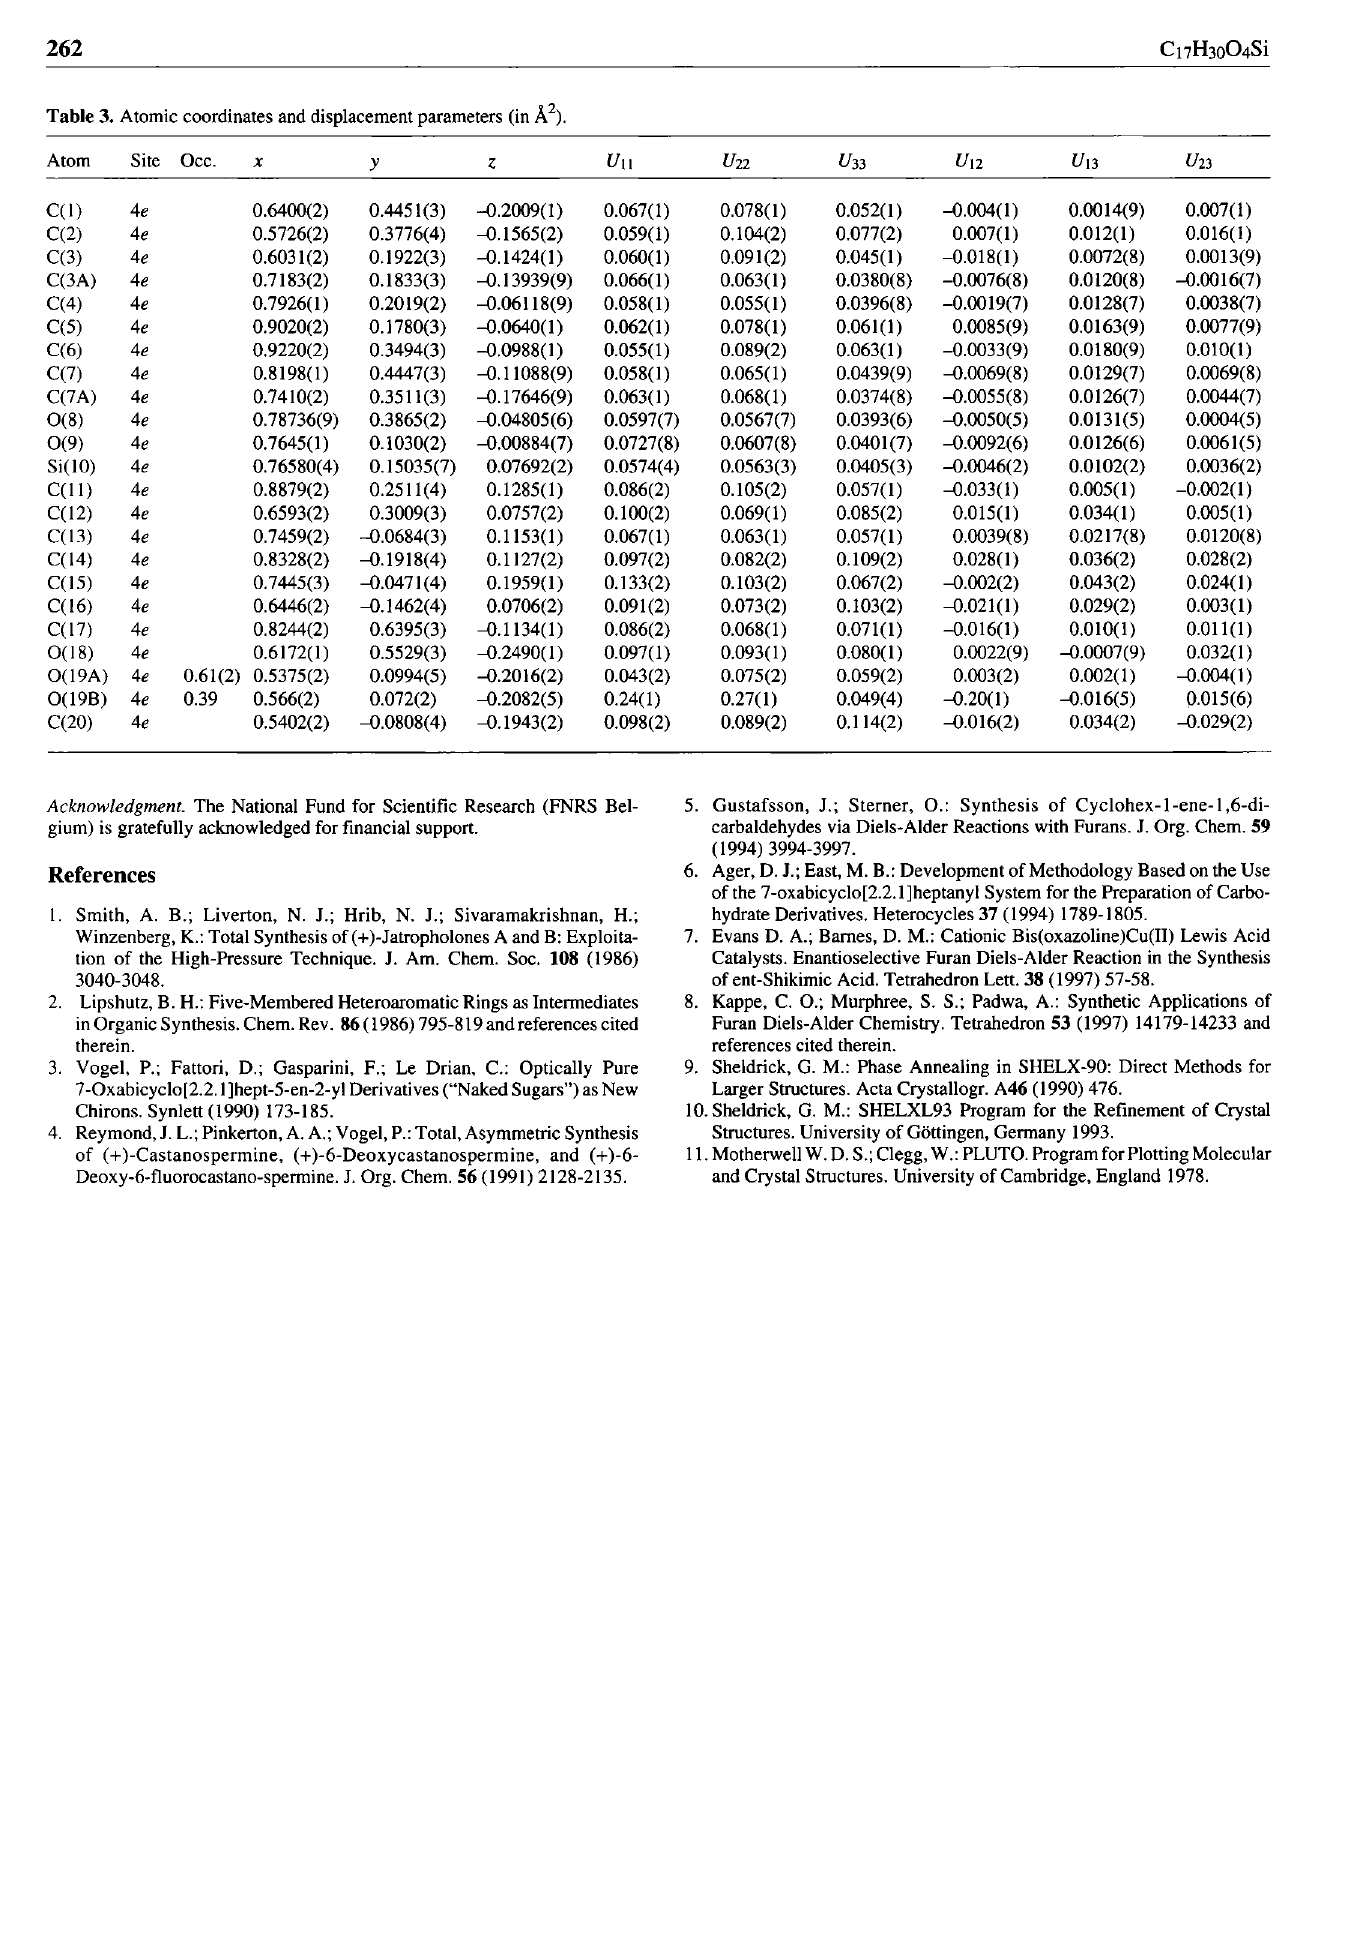
Table 3. Atomic coordinates and displacement parameters (in Ä 2 ). Atom Site